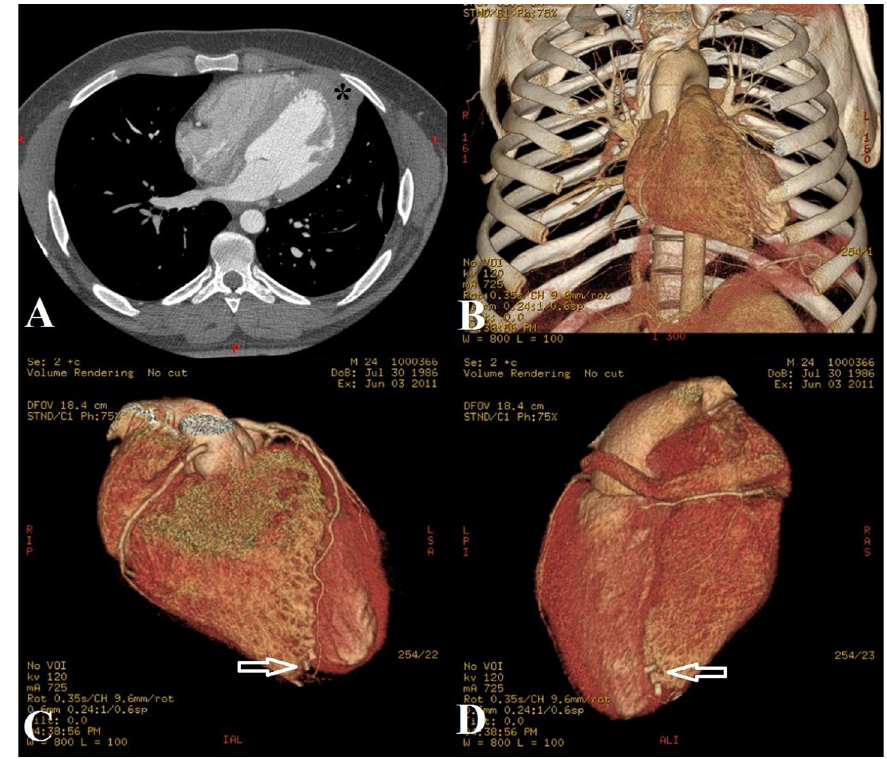
Fig. 2 – A: Possible fibrous formation in the site of wound repair is seen (asterisk). B: Three- dimensional view of the chest and heart. C and D: pledgets used in wound repair in the myocardial apex